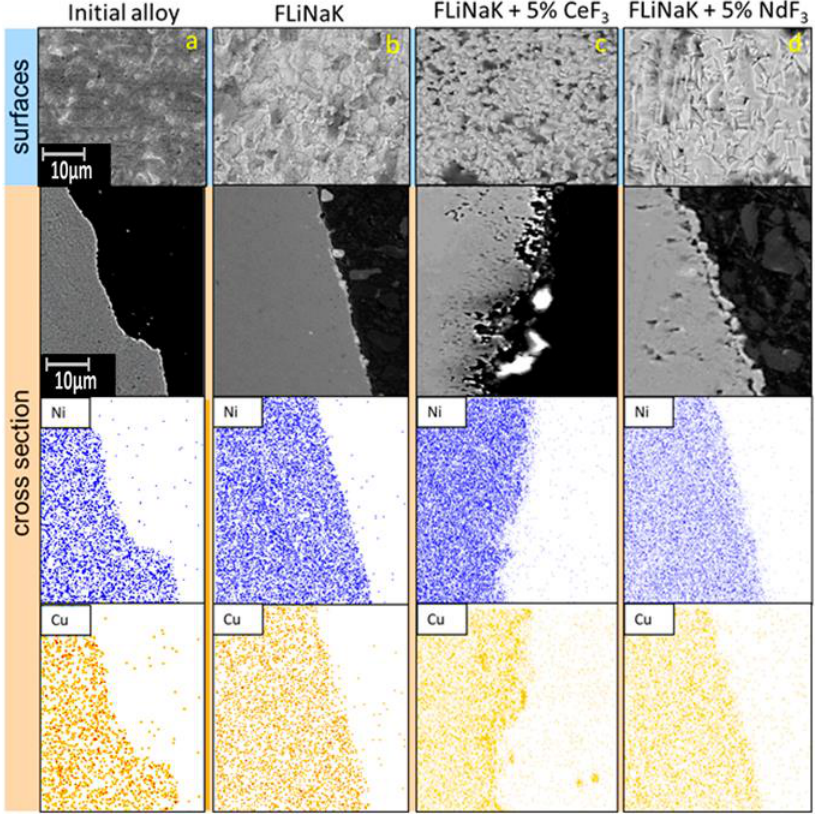
Figure 8. Structure of the surface layers of the Monel 404 samples after long-term corrosion tests: ( a ) initial; ( b ) exposed in FLiNaK; ( c ) exposed in the FLiNaK + 5 wt.% CeF 3 melt; ( d ) exposed in the FLiNaK + 5 wt.% NdF 3 melt.